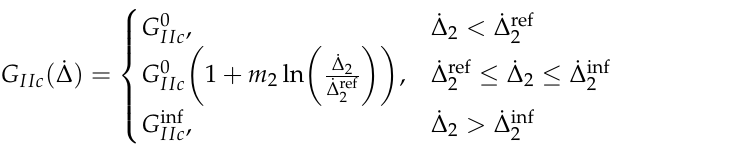
10 − 5 m / s; (b) ˙ w = 10 . 0 m / s [ ? ]. ×